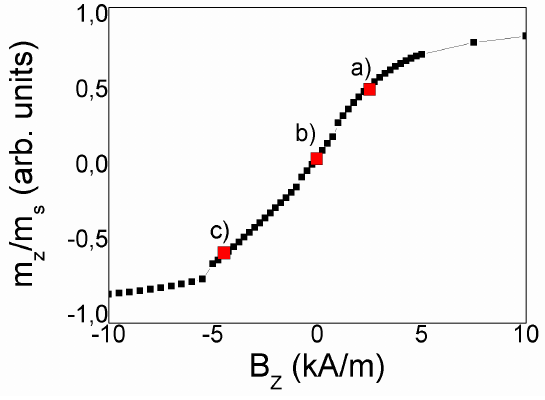
Figure 15. Calculated magnetization reversal curve and the images of spiral domains in cylinder with 1 µ m diameter and 15 µ m length. Images ( a – d ) correspond to the points ( a – d ) in the hysteresis. Electric current is 1 mA.